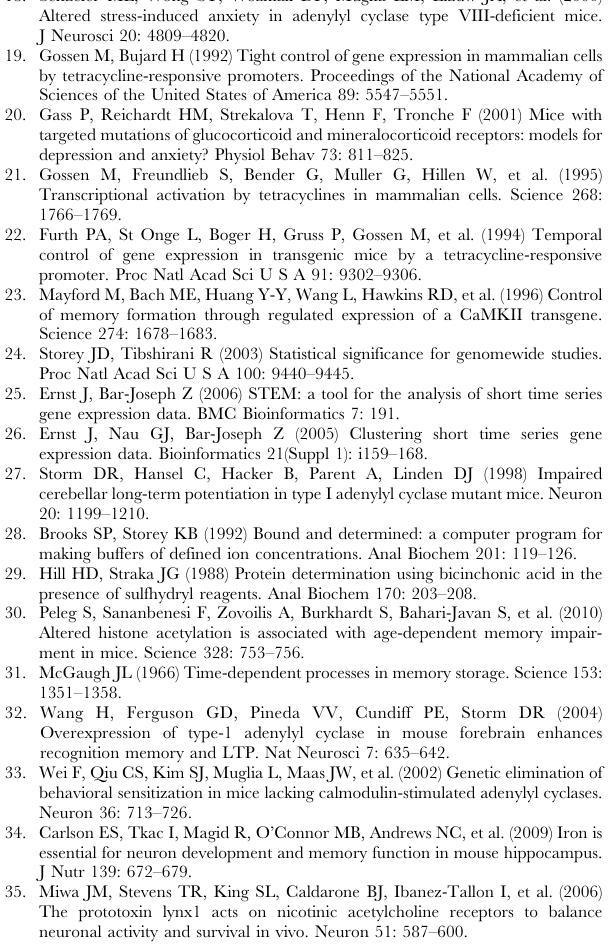
Table S8 Amygdala gene cluster list. The table lists the genes represented within each cluster in the amygdala.